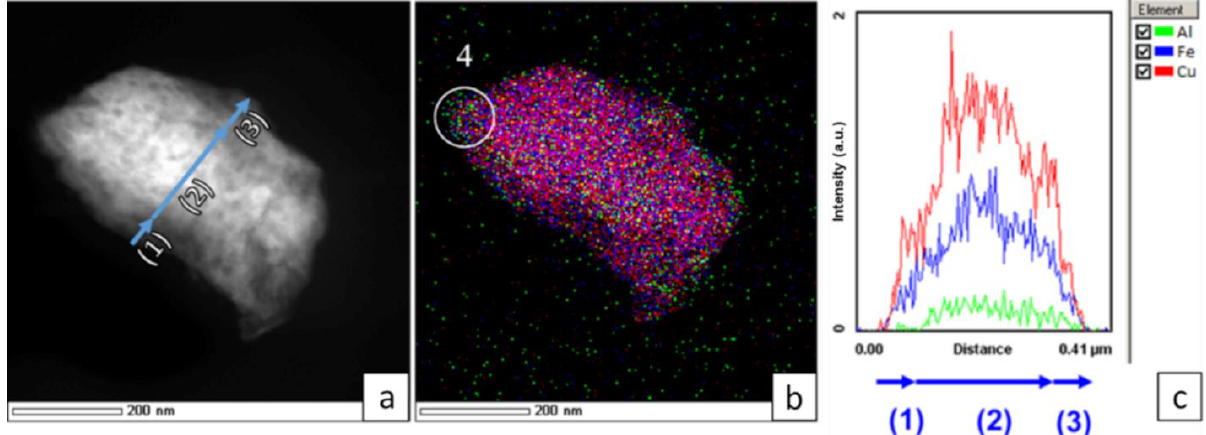
Figure 9. ( a ) STEM-HAADF image of a particle aggregate (Cu+Fe) + Al (24 min), ( b ) superposition of the EDX maps combining Fe, Cu and Al signals showing the element distributions in the 33Al–45Cu–22Fe particle ( a , c ) intensity of Fe K, Cu K and Al K signals along the line shown in ( a ). (1)–(3) different regions of particle at ( a ). Table 5. Atomic percentages of Al, Cu and Fe in regions marked in Figure 8b,c. Element